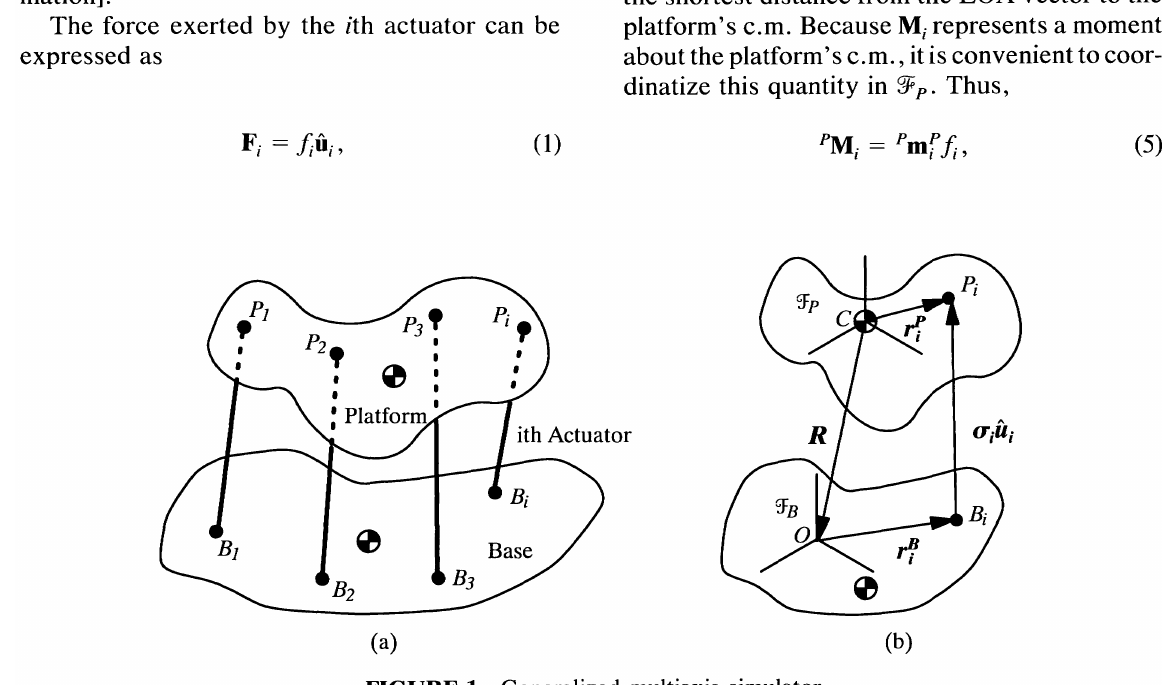
FIGURE 1 Generalized multiaxis